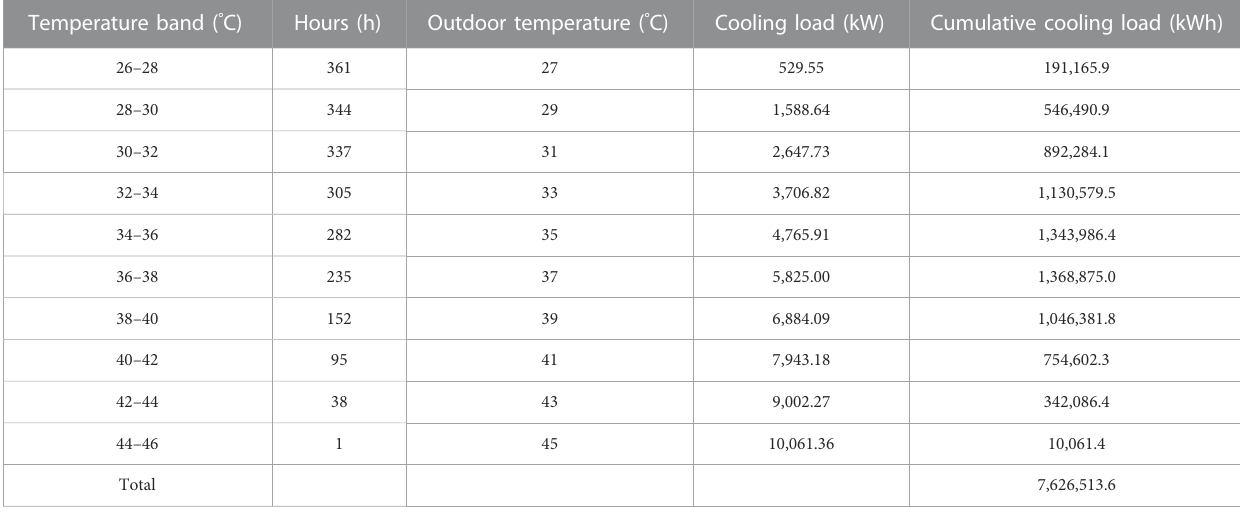
TABLE 7 Cumulative cooling load calculation table of air conditioning in summer. Temperature band ( ° C)